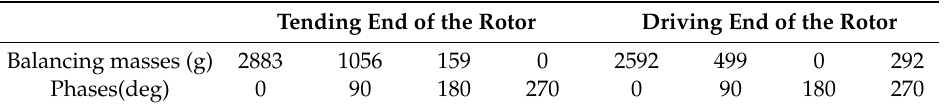
Table 1. Balancing masses and their